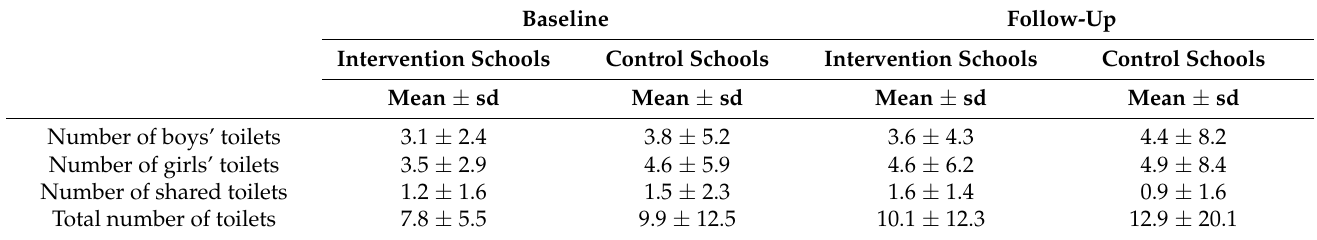
Table 1. Characteristics of intervention and control schools at baseline and follow-up.